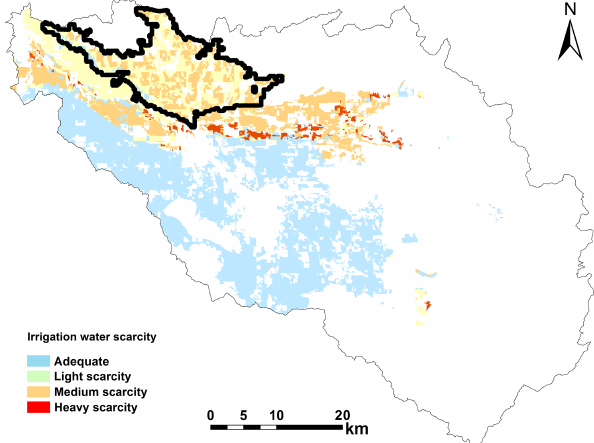
Figure 11. The spatial distribution of the annual unsatisfied irri- gation maps averaged over the simulation period. The domain that is within the thick outline is the Black Canyon irrigation district, which receives additional irrigation water from outside of the do- main, where the water scarcity is overestimated.